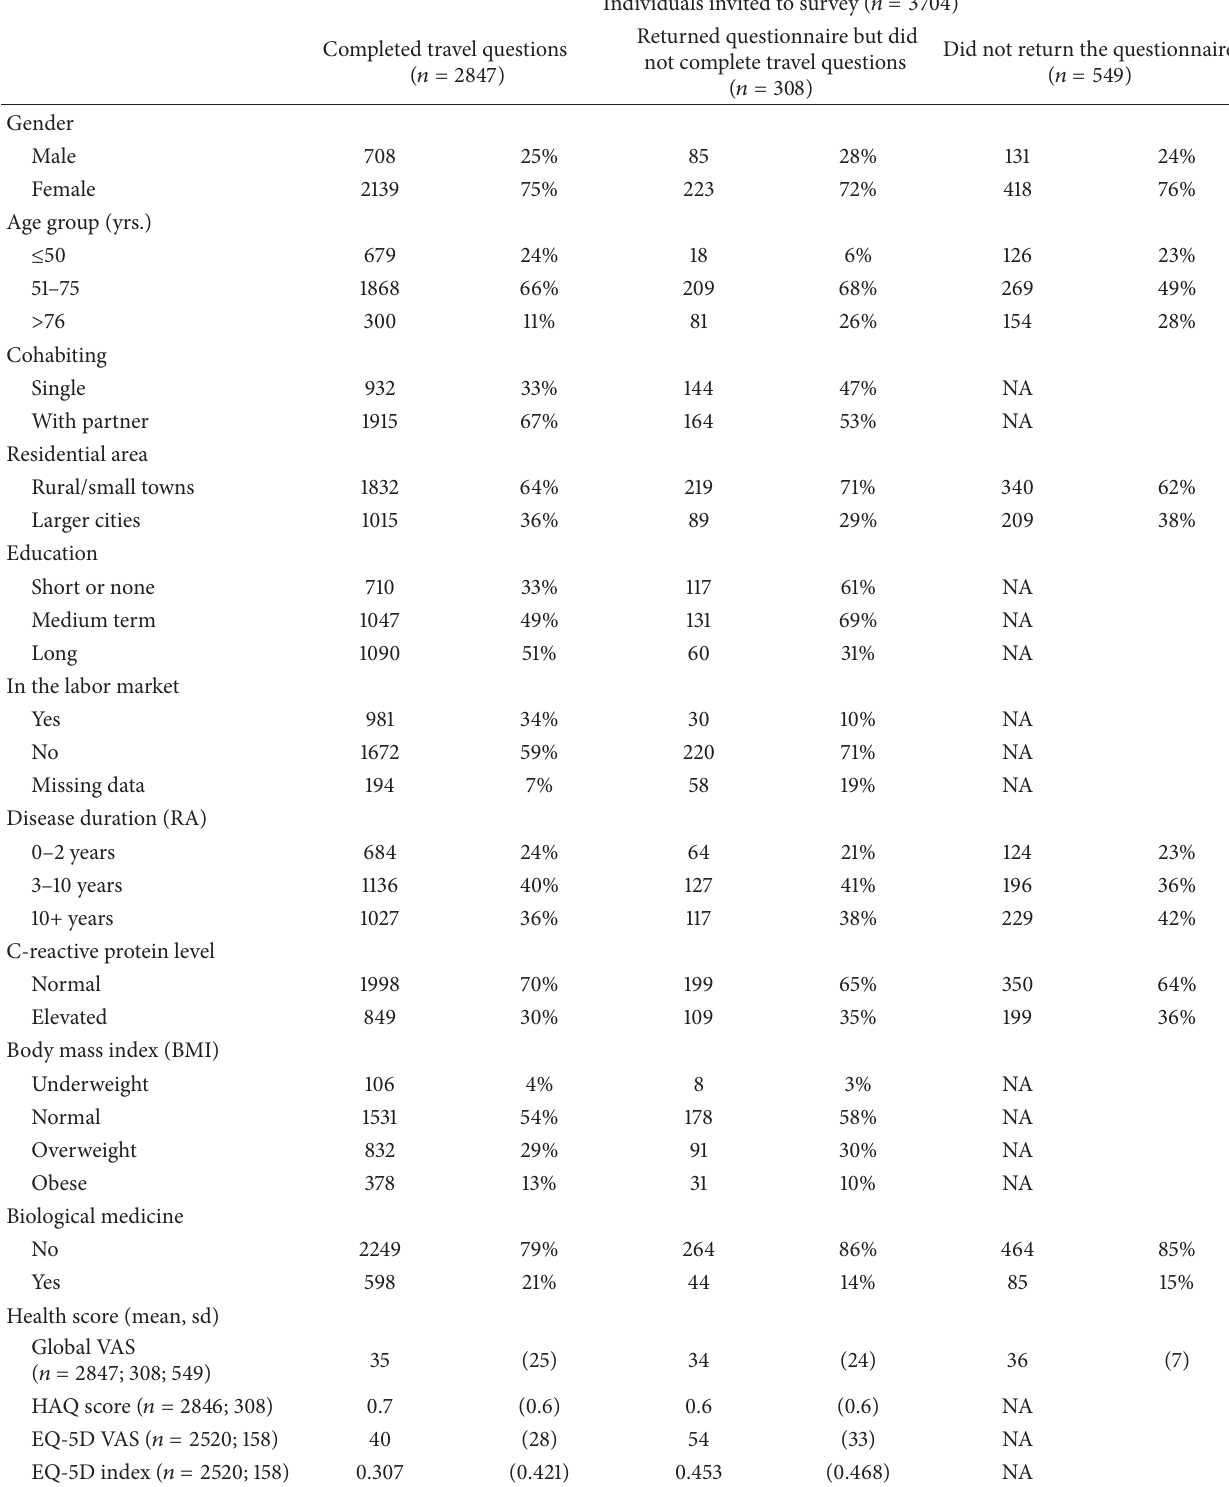
Table 1: Characteristics of patients with rheumatoid arthritis (RA) invited to complete a survey including questions on travel costs to health